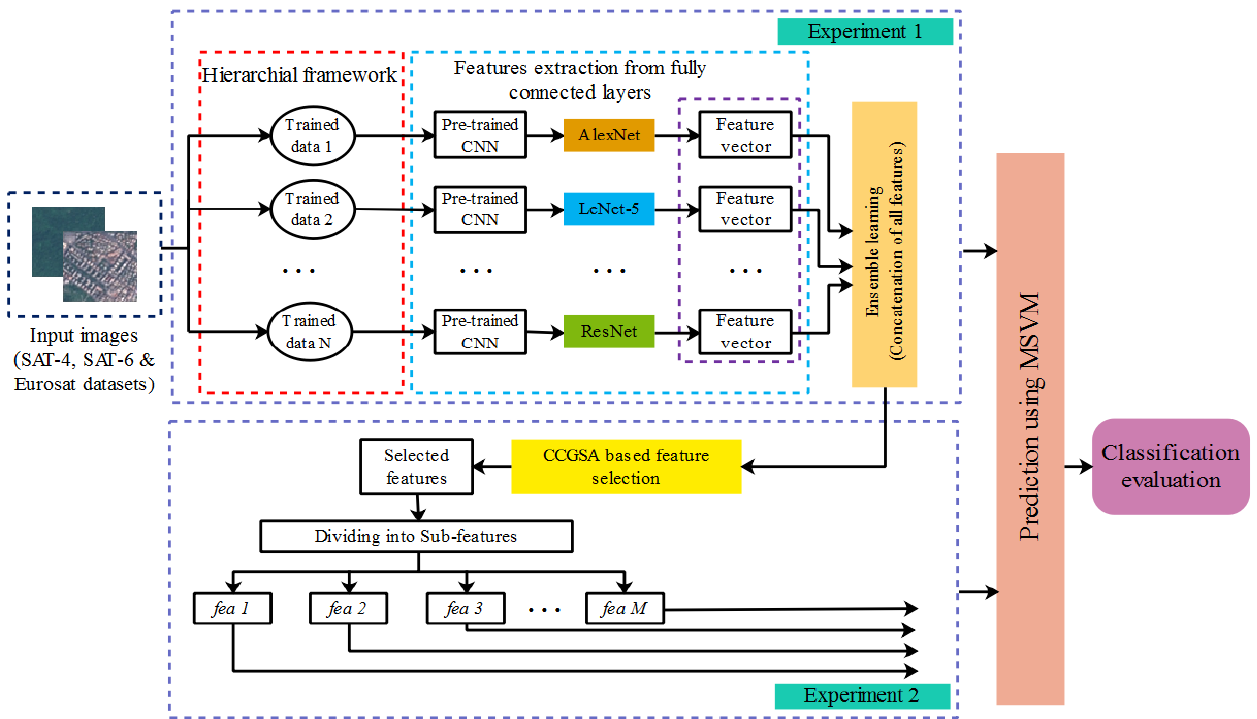
Figure 1. Block diagram of HFEL–CCGSA method.